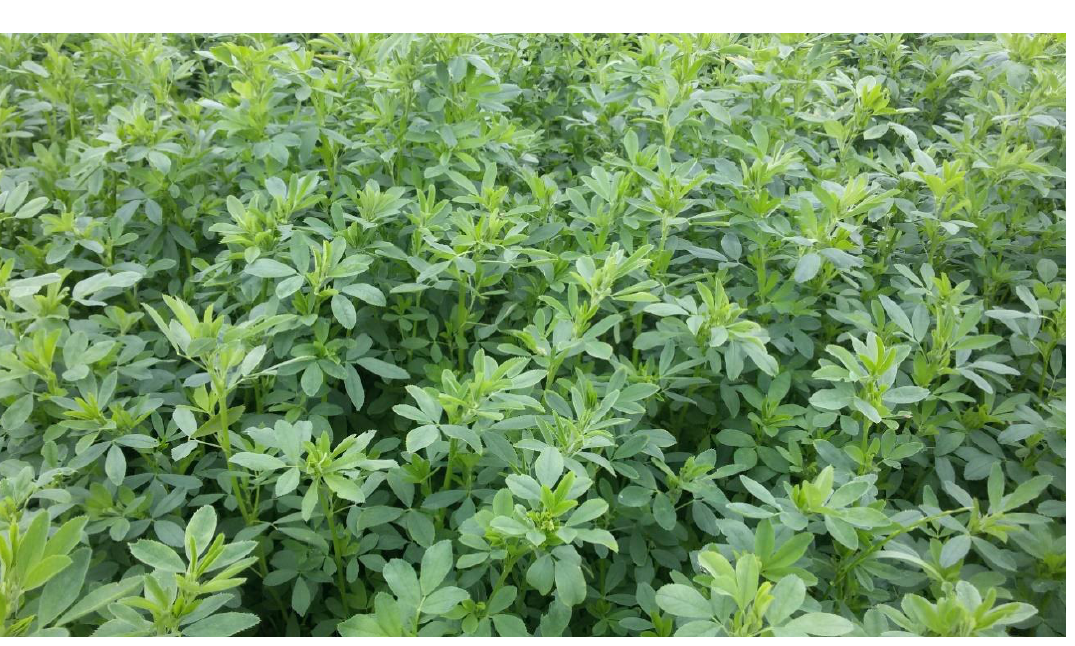
Figure 3. Medicago sativa L. growing on the experimental plot.